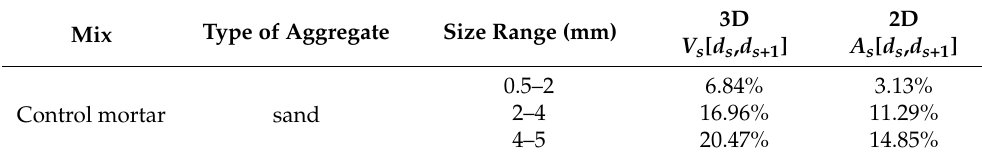
Table 2. 3D gradation and 2D design of sand in the control mortar.